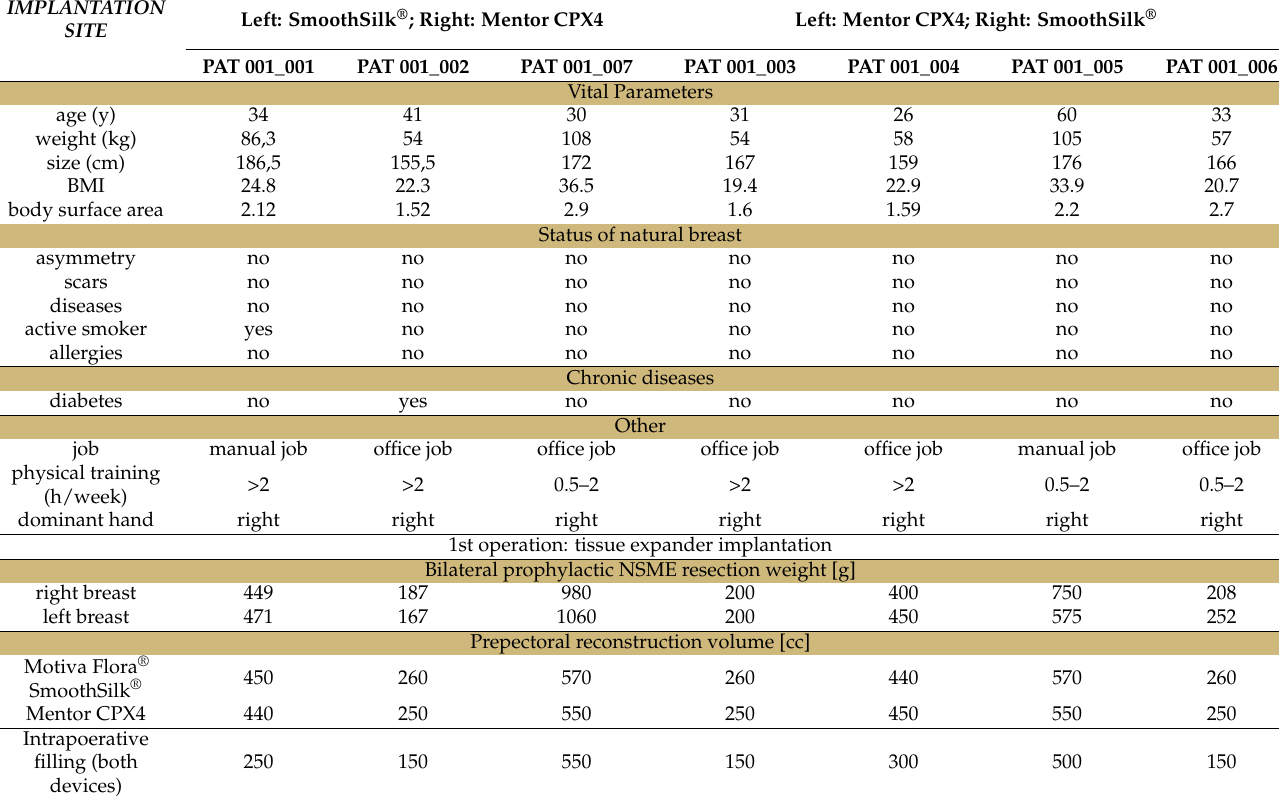
Table 3. Summary of patient demographic characteristics and device